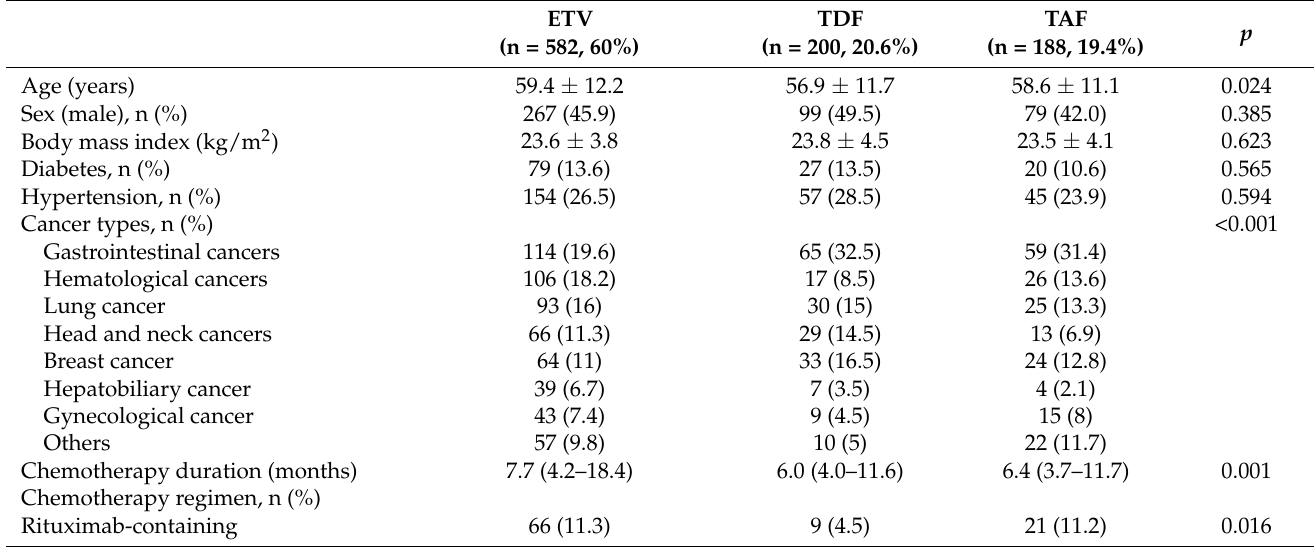
Table 1. Baseline characteristics of the 970 HBV-infected cancer patients receiving chemotherapy.